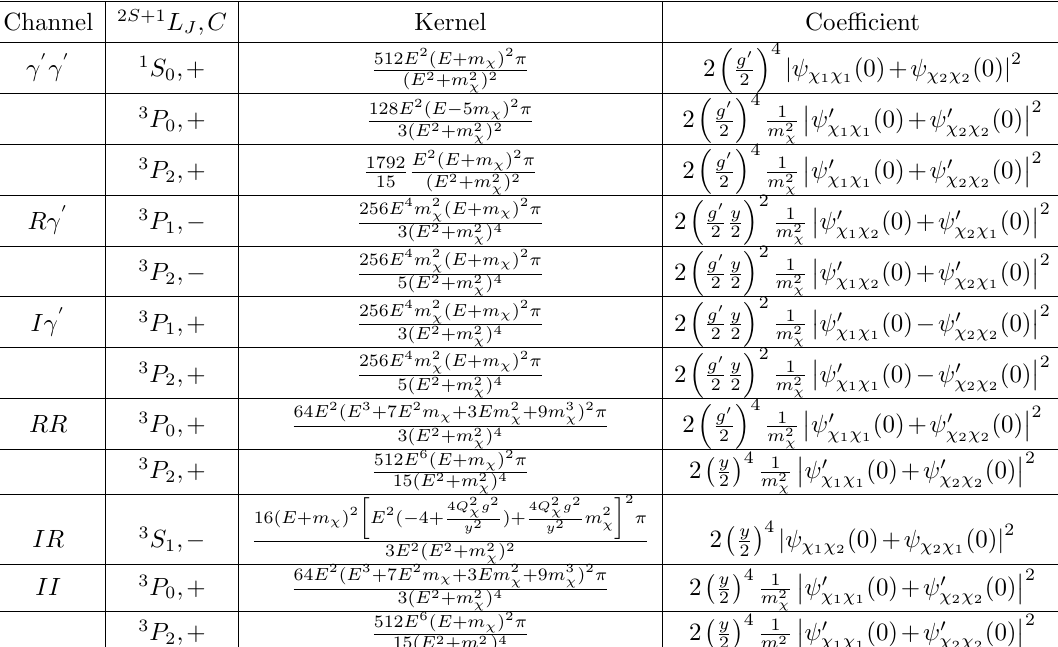
Table 3 . Two-body decay squared matrix elements, phase-space integrated, (cid:12)nal-state summed. For abbreviation, we de(cid:12)ne g 0 = Q (cid:31) g . The \ LSJC " indicates the quantum numbers of the orbital angular momentum, total spin, total angular momentum, and C-parity. Compared with the table 2, the parity is absent, because many states are no longer eigenstates of the parity. Although m (cid:31) m (cid:31) , for simplicity, we still use m (cid:31) as the mass of both (cid:31) 1 and (cid:31) 2 during our calculations. E is the 2 energy of either initiate particle, as we have calculated in the center of mass